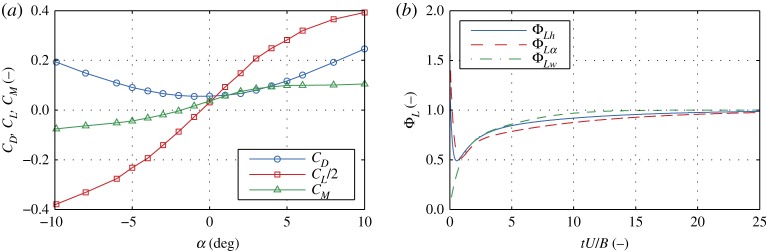
Static wind coefficients (a) and lift indicial functions (b).